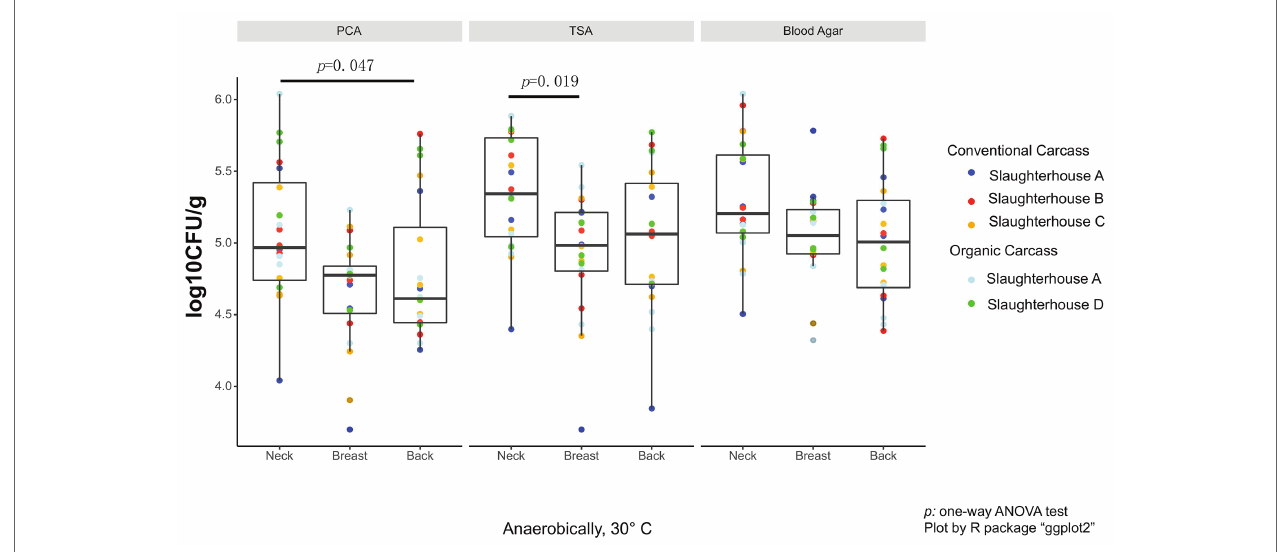
FIGURE 1 | Total anaerobic bacteria (TANAB) counting on analysis plates from three sampling parts (neck, breast, and back